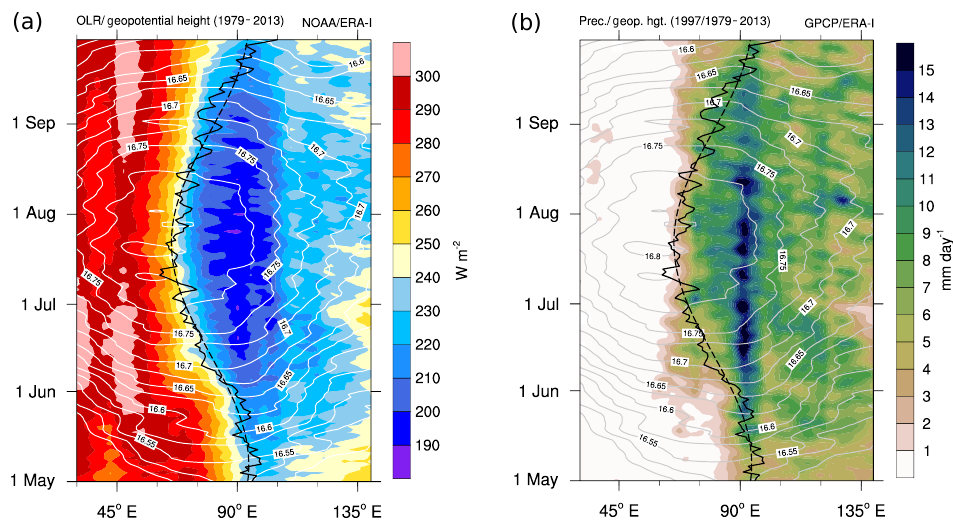
Figure 11. (a) Hovmöller diagram (longitude vs. time) of OLR (NOAA, 15–30 ◦ N average in Wm − 2 ) and geopotential height (km) at 100hPa (ERA-I, 20–40 ◦ N average, white contours) averaged over the years 1979–2013. The black solid line indicates mean location of the SAH centre during the same period. The dashed line represents the low-pass-filtered mean location of the SAH, i.e. periods less than 80 days are removed from the black solid line. (b) As in panel (a) but colour coded is GPCP daily precipitation (mmday − 1 ) at 1 × 1 ◦ resolution averaged over 15–30 ◦ N during the years 1997–2013. Precipitation data has been smoothed by 3 ◦ longitudinally and 3 days temporally.